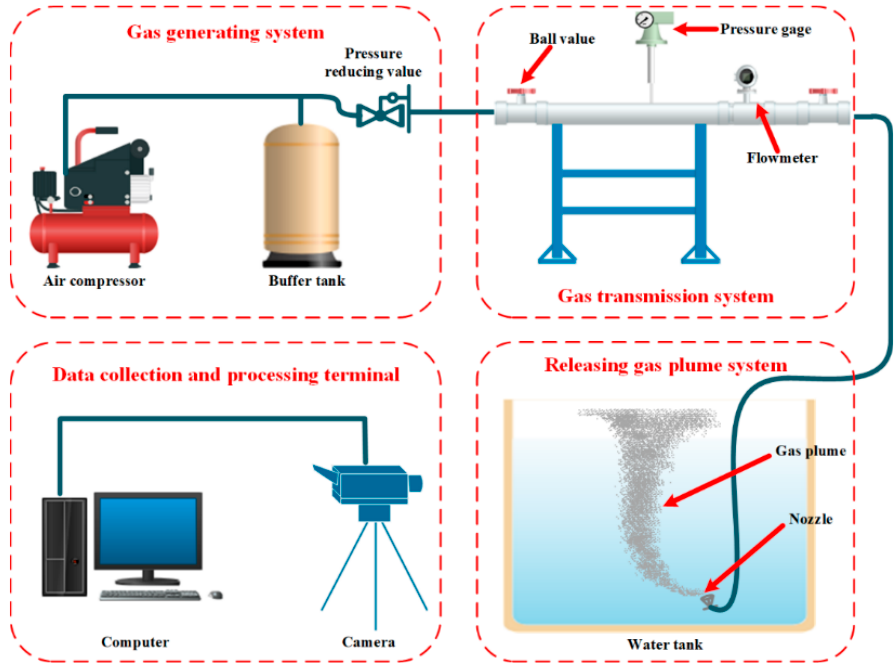
Figure 4. The overall architecture of the experiment system for underwater gas leakage.